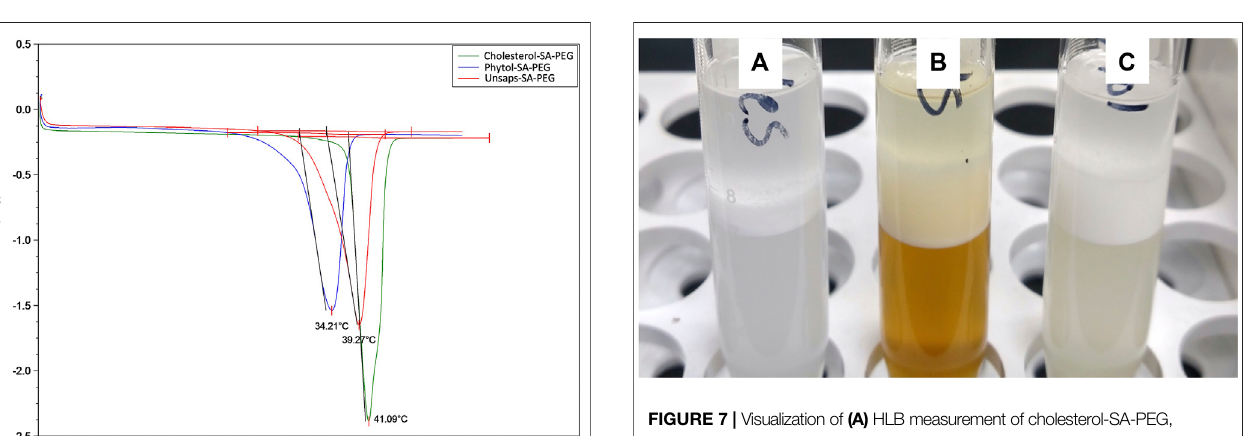
FIGURE 7 | Visualization of (A) HLB measurement of cholesterol-SA-PEG, (B) unsaponi fi ables-SA-PEG, and (C)